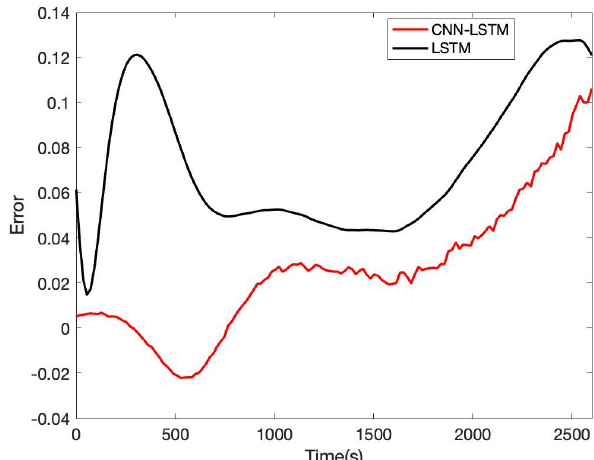
Figure 22. Battery SOE prediction error of B0007.